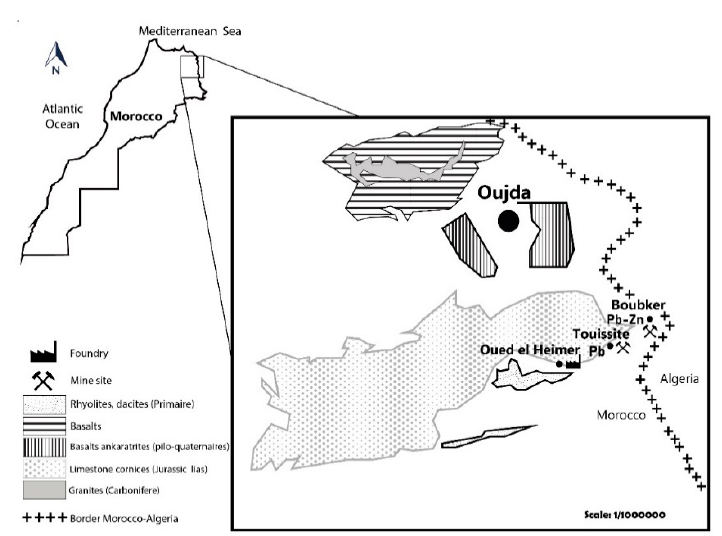
Figure 3. Geology of the Touissite area (Ministry of energy and mines geology department, 1985).